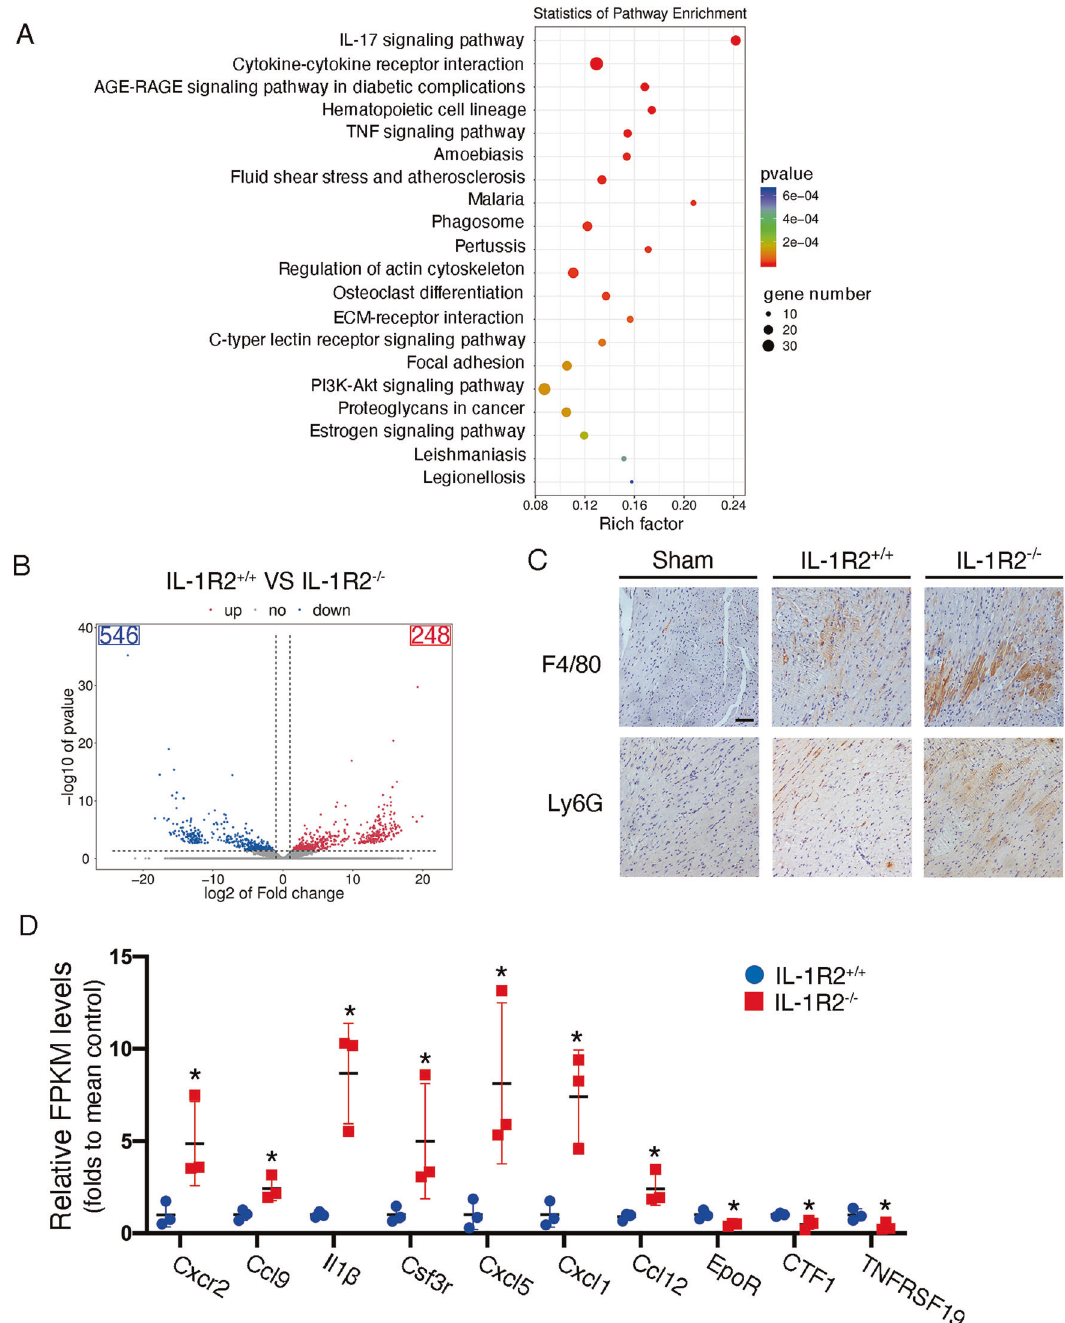
Fig. 4 Knockout of IL-1R2 induces cytokines expression in the heart after I/R injury. A A bubble chart showing KEEG pathways enrichment in IL-1R2 + / + and IL-1R2 − / − mice. B The volcano diagram displays the differentially expressed protein in IL-1R2 + / + and IL-1R2 − / − mice. C Representative images of F4/80 + or Ly6G + areas in the heart through immunochemical staining of heart from Sham, IL-1R2 + / + , and IL-1R2 − / − mice subjected to myocardial I/R surgery. D Relative FPKM levels of chemokine genes related to cytokine-cytokine receptor interaction are shown ( n = 3). The differentially expressed mRNAs and genes were selected with log2 (fold change) > 1 or log2 (fold change) < − 1 and with statistical signi fi cance ( p -value < 0.05). cell-cultured medium, which indicated that elevated sIL-1R2 level independently relevant with parameters of LV adverse remodeling derived from damaged cardiomyocyte after I/R injury. Besides following ST-Elevation Myocardial infarction (STEMI), which neutrophils and monocytes, we reported for the fi rst time that suggested that sIL-1R2 could be a promising cardiac remodeling injured cardiomyocytes also contributed to producing IL-1R2 marker [32]. Previous reports have shown that circulating IL-1R2 during the pathogenesis of I/R injury. What is more, we also was mainly expressed by neutrophils and monocytes under observed that global knockout of IL-1R2 worsens cardiac in fl ammatory conditions [18, 33]. Here, we found that upon H/R dysfunction and increased cardiomyocyte apoptosis during I/R stimulation, NRVM accumulated sIL-1R2 both in the cytoplasm and